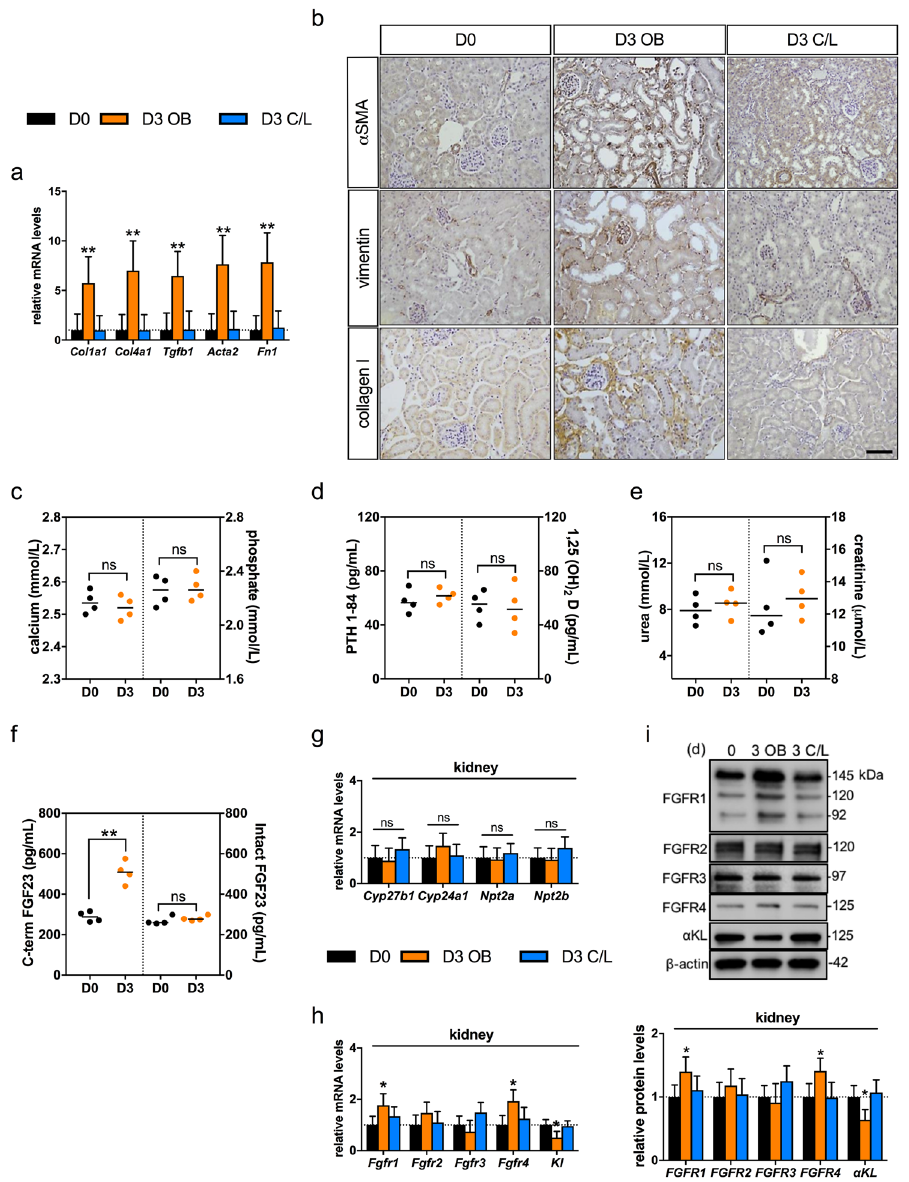
Figure 1. UUO has no acute effect on systemic mineral metabolism in mice. ( a ) qRT-PCR analysis of fibrosis- related gene expression in tissue isolated 3 days post UUO (D3) from obstructed (OB) and unobstructed contralateral (C/L) kidneys relative to levels in control animals (D0). Fibrogenic targets were collagen alpha-1(I) chain ( Col1a1 ), collagen alpha-1(IV) chain ( Col4a1 ), transforming growth factor- β 1 ( Tgf b1 ), α -smooth muscle actin ( Acta2 ) and fibronectin ( Fn1 ) (n = 4 mice for each group). ( b ) Representative DAB immunohistochemical staining for α SMA, vimentin and collagen I in control D0, D3 OB and D3 C/L kidneys. Counter staining was performed with haemotoxylin. Scale bar: 100 μ m. ( c–f ) Serum levels of calcium and phosphate ( c ), PTH 1–84 and 1,25(OH) 2 vitamin D ( d ), urea and creatinine ( e ) and intact and C-terminal FGF23 ( f ) in control D0 animals and D3 UUO animals (n = 4 mice for each group). ( g , h ) qRT-PCR analysis of FGF23 target gene expression ( g ) and FGFR receptor/co-receptor gene expression ( h ) in tissue from obstructed (D3 OB) and unobstructed contralateral kidneys (D3 C/L) relative to transcript levels in control animals (D0). FGF23 target gene expression transcripts included 25-hydroxyvitamin D-1 alpha hydroxylase ( Cyp27b1 ), 1,25-dihydroxyvitamin D(3) 24-hydroxylase ( Cyp24a1 ), Sodium-dependent phosphate transport protein 2A ( Npt2a ) and Sodium-dependent phosphate transport protein 2B ( Npt2b ). Fibroblast growth factor receptor (FGFR)/co-receptor targets included Fgfr1-4 and a -Klotho (Kl). (n = 4 mice for each group). ( i ) Representative Western blot analysis of FGFR receptor/co-receptor levels in D0, D3 OB and D3 C/L kidney homogenates. β -tubulin was used as a loading control. Quantification of the receptor/ β -tubulin signal ratios normalised ( = 1.0) to control D0 levels (n = 4 mice for each group). Data are shown as mean ± SD. * P < 0.05; ** P < 0.01; ns, not significant. P-values were determined in ( a , g – i ) by one-way ANOVA with Holm-Sidak multiple comparisons test; ( c – f ), by two-tailed unpaired Student’s t